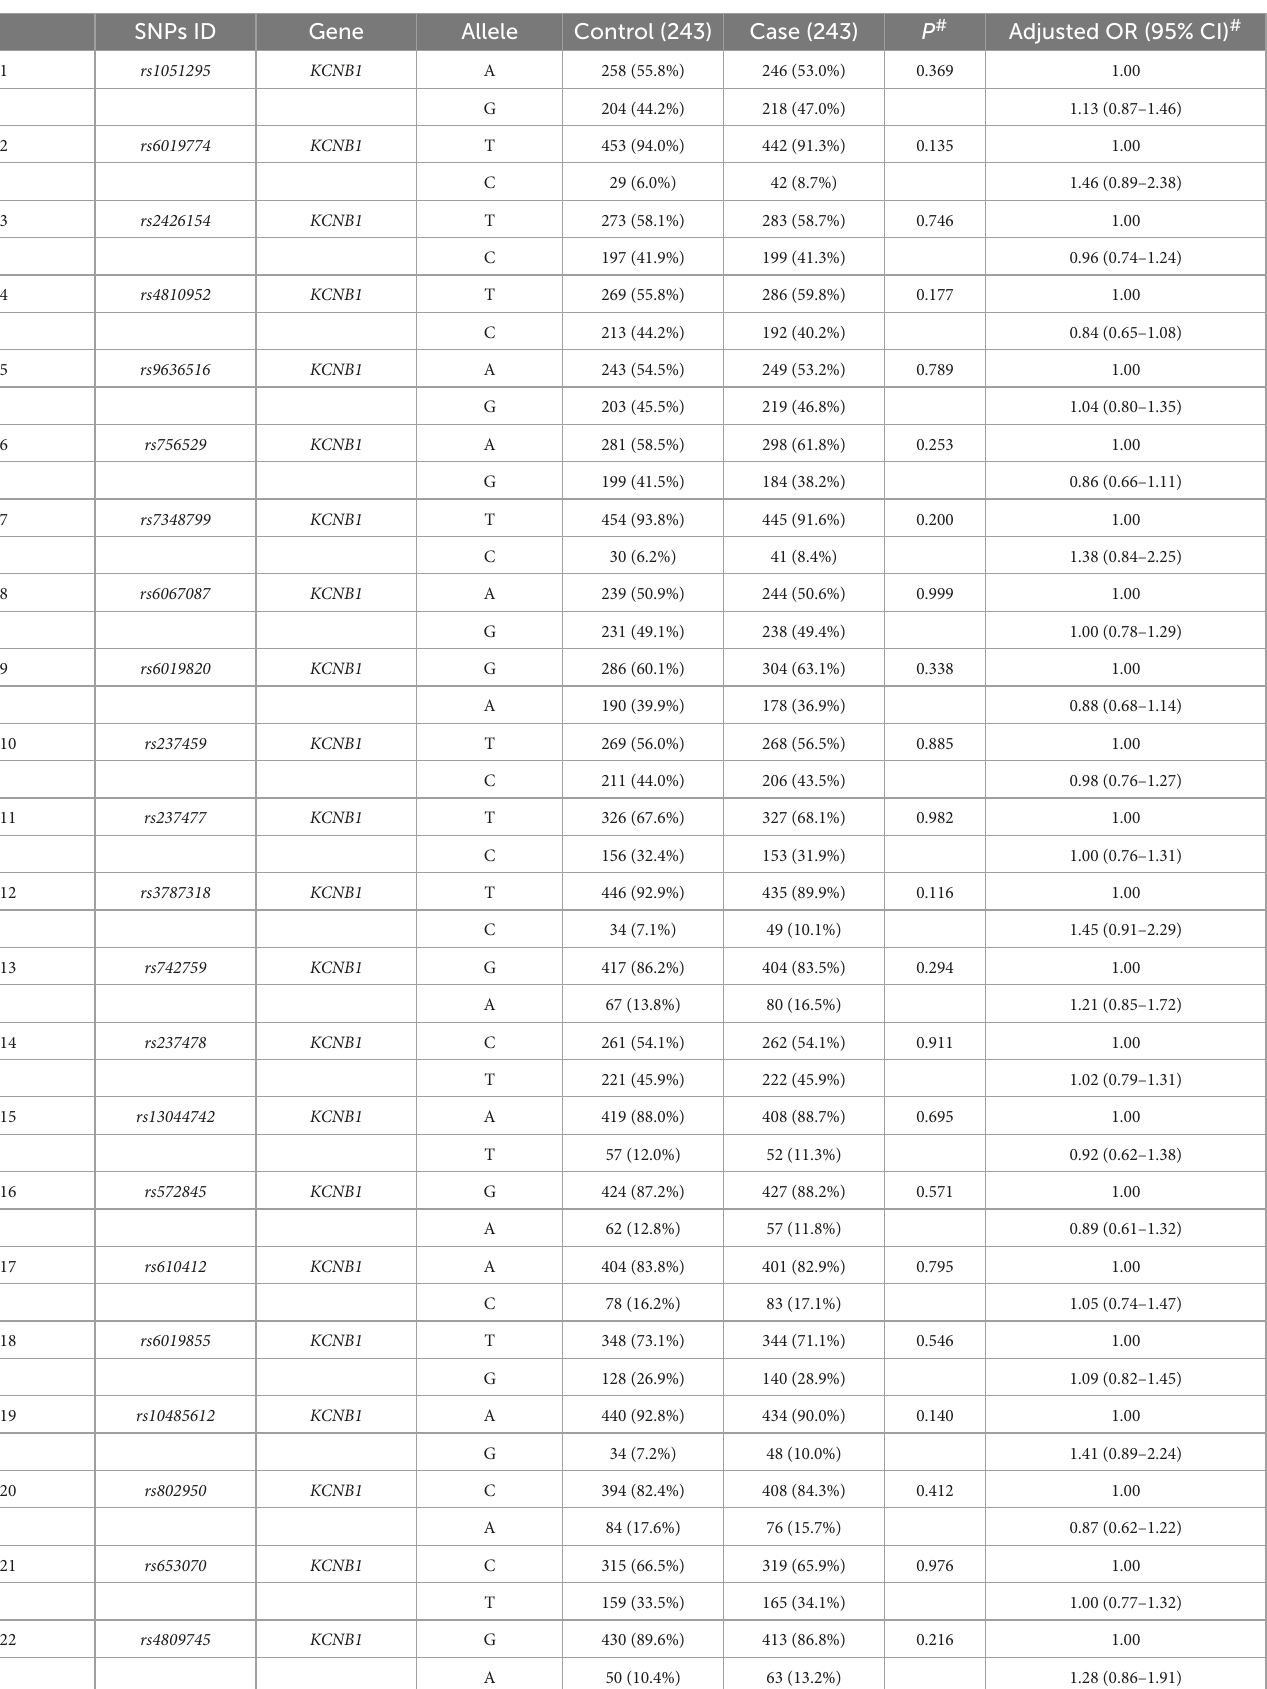
TABLE 3 Distribution of allele frequencies of KCNB1 single nucleotide polymorphisms (SNPs) in cases and controls (n,